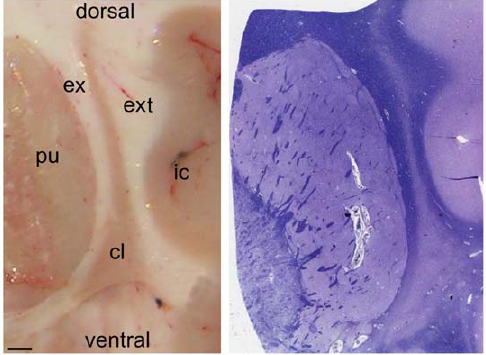
Figure 1. Claustrum localization in the brain. Photographs of a coronal section of a post-mortem specimen (left) and a Luxol fast blue stained section (right) showing the anatomical correlation between the claustrum (cl) and the adjacent structures. pu, putamen; ic, insula cortex; ex, external capsule; ext, extreme capsule. Scale bar, 1 mm.